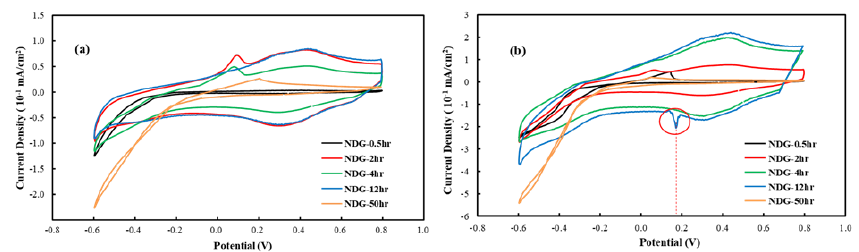
Fig. 6. Cyclic voltammogram of all samples. (a) N2 Saturated; (b) O2